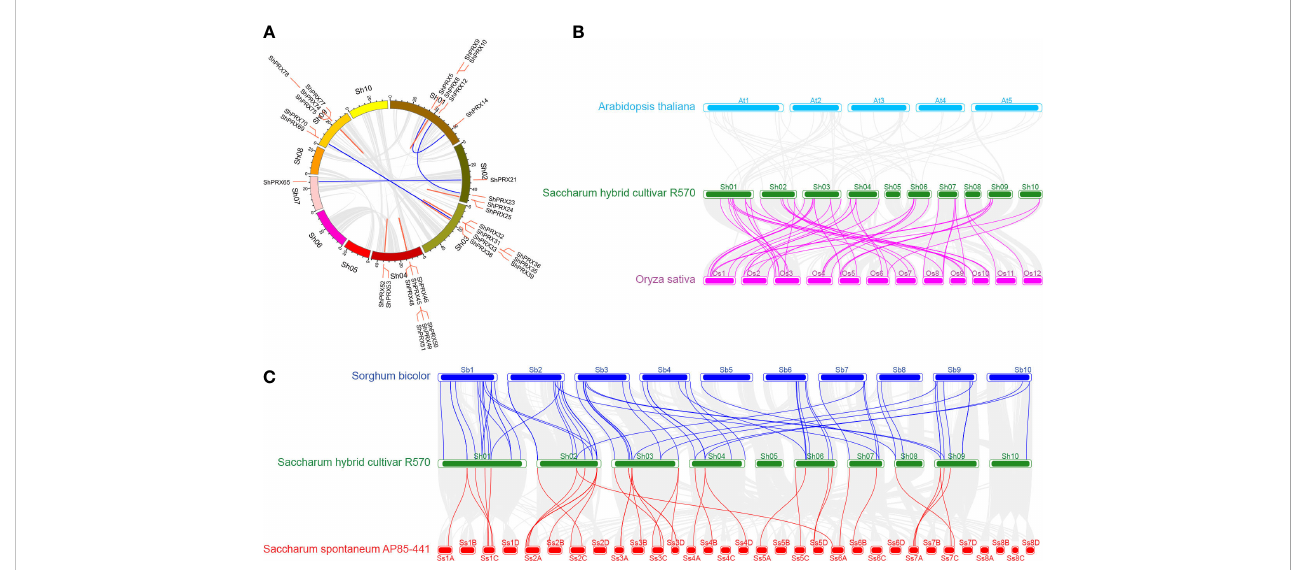
FIGURE 5 Syntenic analysis of PRX gene family in Sugarcane, A. thaliana , O. sativa , S. bicolor , and S. spontaneum . (A) Syntenic analysis of PRX gene family in sugarcane. Red lines represent tandem duplication PRX gene pairs, and blue lines represent segmental duplication PRX gene pairs. (B) Syntenic analysis of PRX gene family in Sugarcane, A. thaliana , and O. sativa. (C) Syntenic analysis of the PRX gene family in Sugarcane, S. bicolor , and S. spontaneum